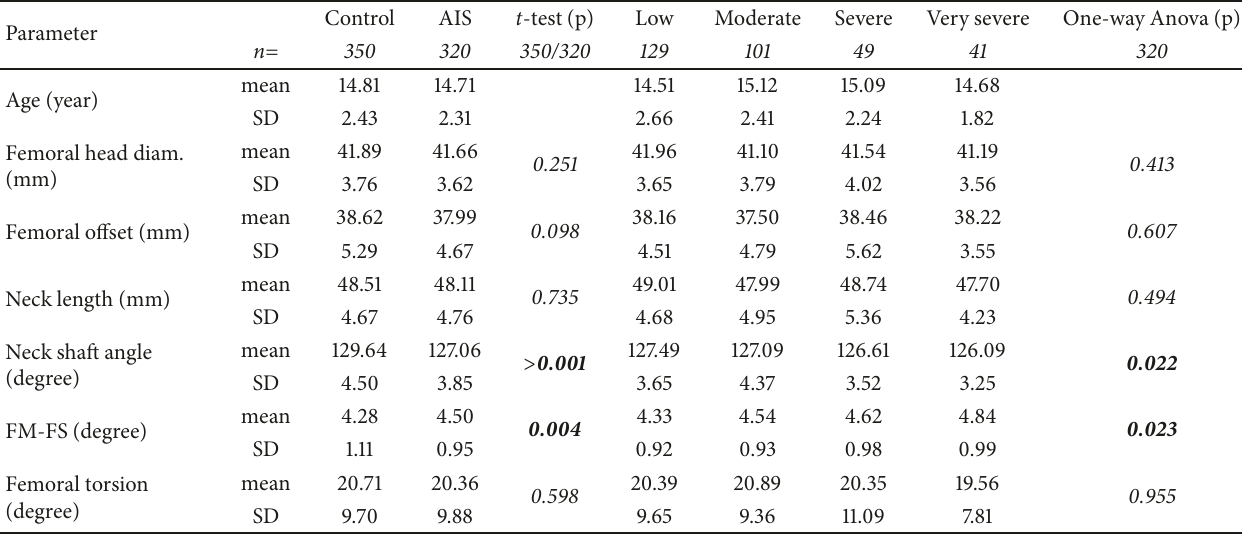
Table 3: Mean and standard deviation (SD) of the examined parameters and the results of t -test and ANOVA. Parameter